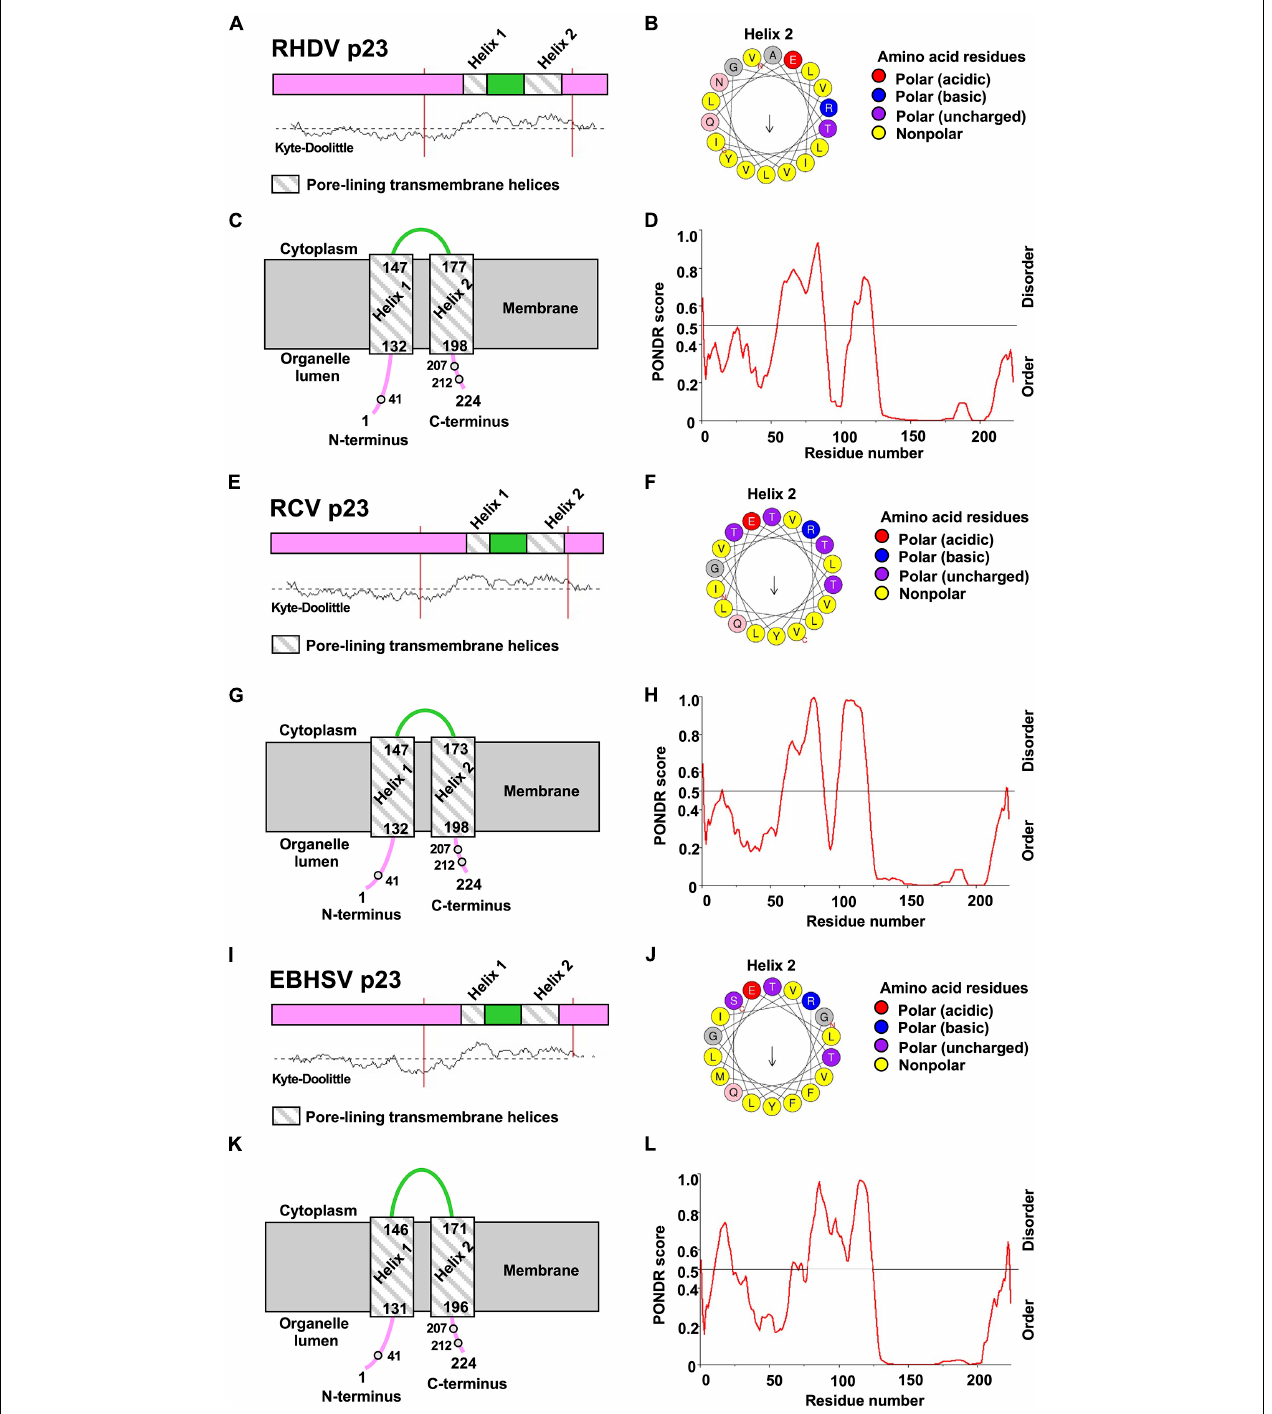
FIGURE 3 | Prediction of transmembrane helices and disordered regions using in silico sequence analyses. (A–D) p23 protein sequences from Rabbit haemorrhagic disease virus (RHDV/GI.1; NC_001543.1), (E–H) Rabbit calicivirus (RCV/GI.4; MF598302.1), and (I–L) European brown hare syndrome virus (EBHSV/GII.1; NC_002615.1). (A,C,E,G,I,K) PSIPRED secondary structure prediction with MEMSAT-SVM algorithm and Kyte-Doolittle hydropathy plot revealed the presence of two putative transmembrane helices in the p23 proteins of all lagoviruses examined. The helices (‘helix 1’ and ‘helix 2’) are shown as striped boxes. (D,H,L) PONDR plot shows predicted disordered and ordered regions; the strength of the prediction is indicated by the score on the y -axis ( > 0.5 are considered disordered). (B,F,J) HeliQuest was used to generate a wheel diagram for the amino acid sequence of ‘helix 2.’ Arrows represent direction and magnitude of the hydrophobic moment. Note that the orientation of p23 within the membrane is not